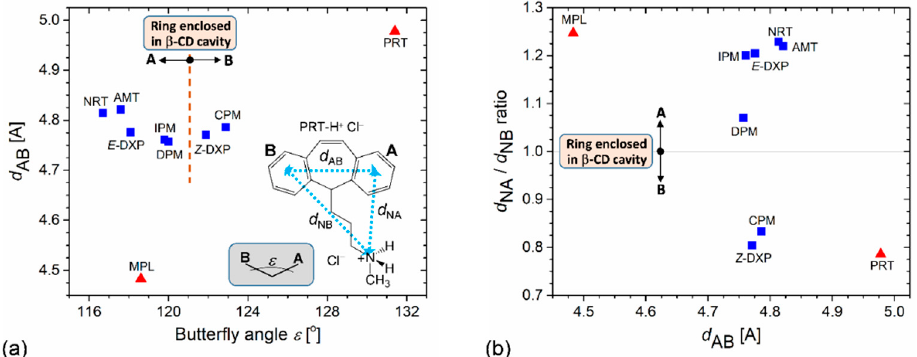
Figure 2. Scatter plots of ( a ) butterfly angle ε vs. distance d AB and ( b ) distance d AB vs. d NA / d NB ratio of PRT ( 1 ) and MPL ( 2 ) in comparison to six β -CD–TCA complexes (NRT, AMT, DPM, IPM, CPM, and E / Z -DXP) [23,28,35] are shown in red triangles and blue squares . All TCA drugs are in HCl salt form. For more details, see Table 2. The TCA A/B-ring enclosed in the β -CD cavity is emphasized. The inset in ( a ) gives the chemical structure of PRT-H + Cl − and the definitions of relevant distances and the butterfly angle. The estimated uncertainties of angle and distance are about the legend width and one-half legend width, respectively.